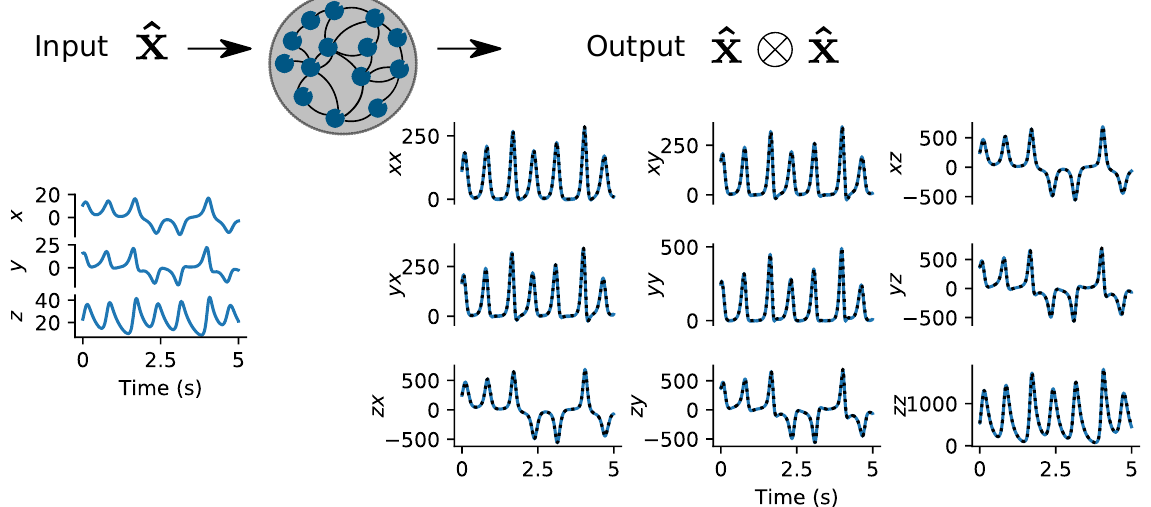
Supp. Fig. S3 – Representation of the Kronecker product of the input . The Input ˆ x was given by a network which computed a Lorenz system. The second network, using eq. (23), out- ˆ x ˆ x . Blue lines represent network output, black dotted lines represent puts a signal ≈ ⊗ ˆ x the real ˆ x ⊗